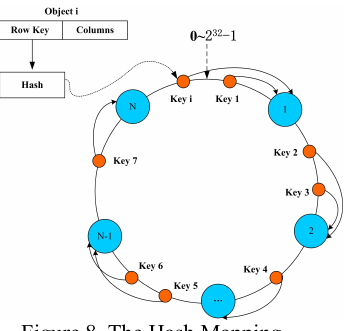
Figure 8. The Hash